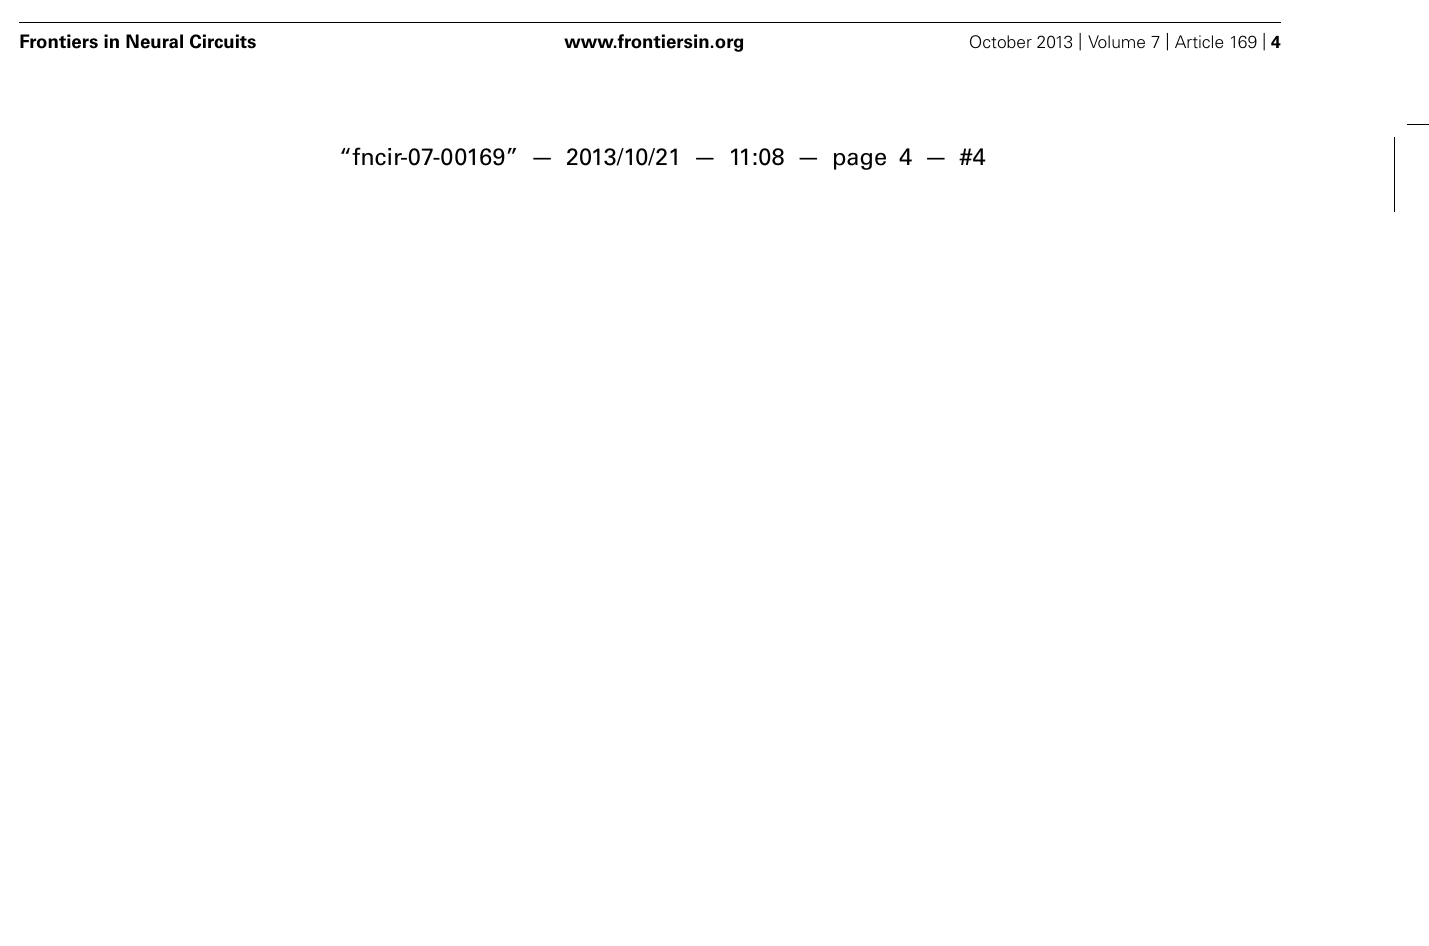
FIGURE 2 | DA-enables activity-dependent alterations in LP I h . (A) The protocols used to measure DA- and/or activity-induced changes in LP I h are diagramed in the top two panels. Asterisks indicate points where TEVC measures of LP I h were made. Bottom panels show typical LP I h recordings at t = 0 and t = 10 min for each of the four the indicated treatment groups; scale bars: 500 ms and 5 nA. Note that distal compartments of LP neurons are not completely space clamped and oscillatory activity at t = 0 was observed in all treatment groups in ∼ 20%